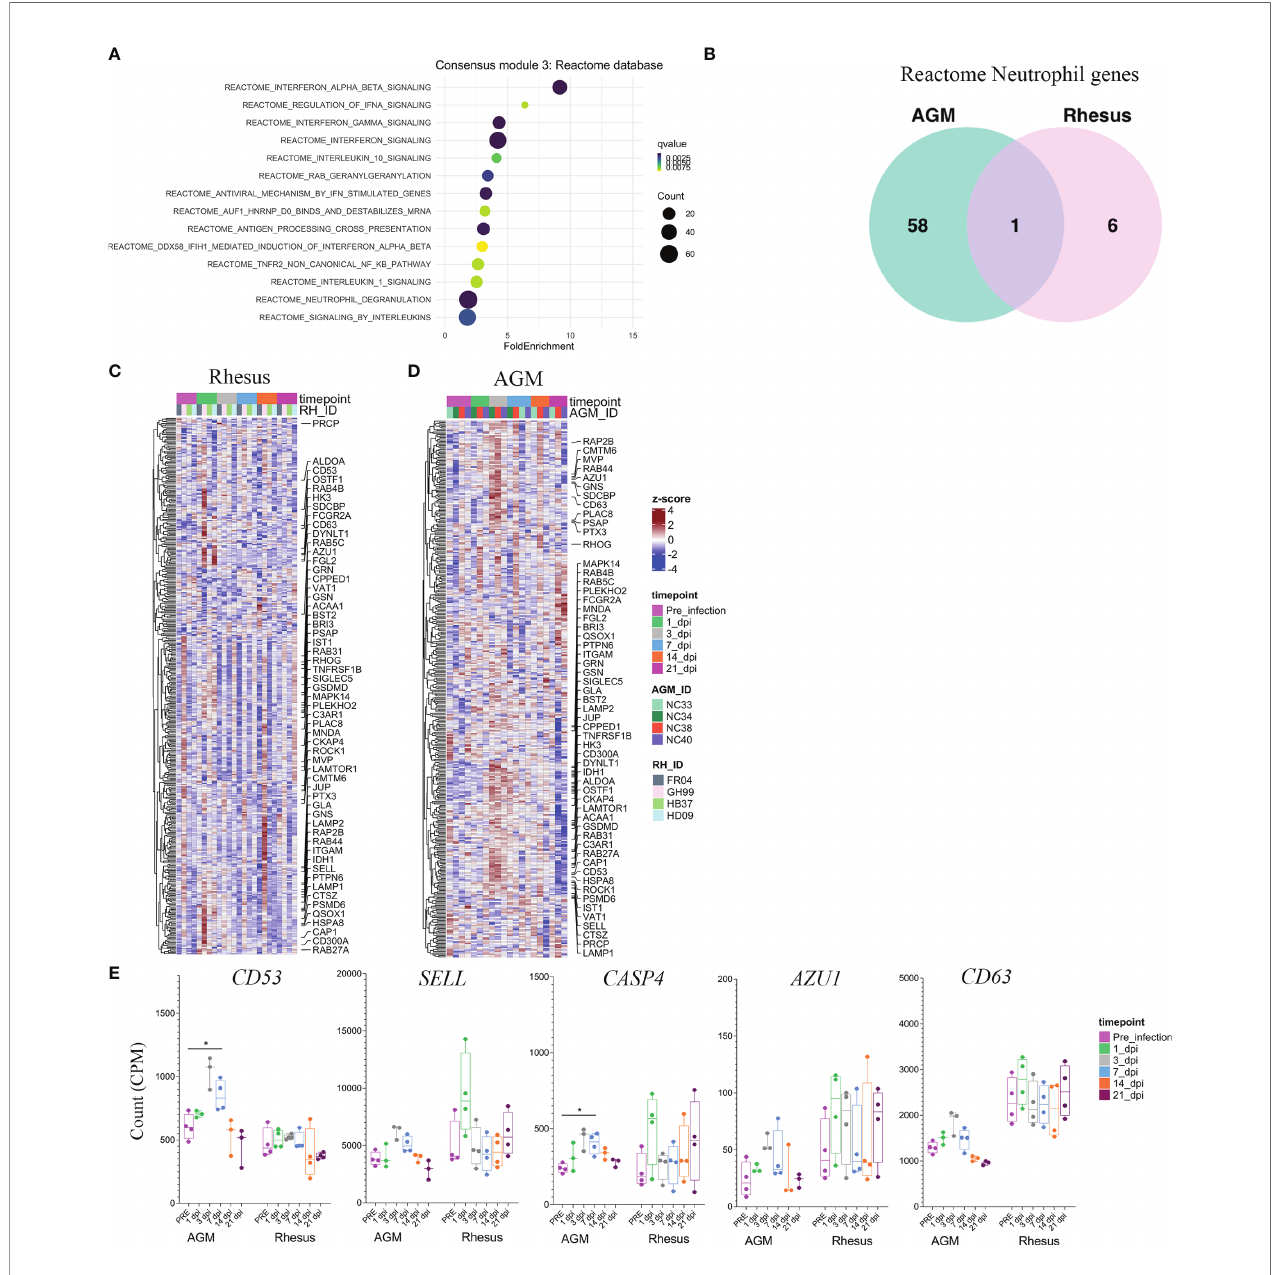
FIGURE 4 | Biological pathways related to neutrophil degranulation are unique to the AGM SARS-CoV-2 response. (A) Pathway analysis of genes comprised in consensus module 3 according to the Reactome pathway database. (B) Venn diagram of neutrophil degranulation genes comprising consensus module 3 that are shared between species and those that are unique between RM and AGM. Heatmaps comprising all genes in the neutrophil degranulation pathway in RM (C) and AGM (D) . Annotated genes represent those within the neutrophil degranulation pathway present in consensus module 3 shared bewteen species. (E) Selected neutrophil degranulation genes with relavance to SARS-CoV-2 pathogenesis. Signi fi cance by a Fisher ’ s Exact test in (A) and a non-parametric Mann-Whitney U test in (E) . *p <